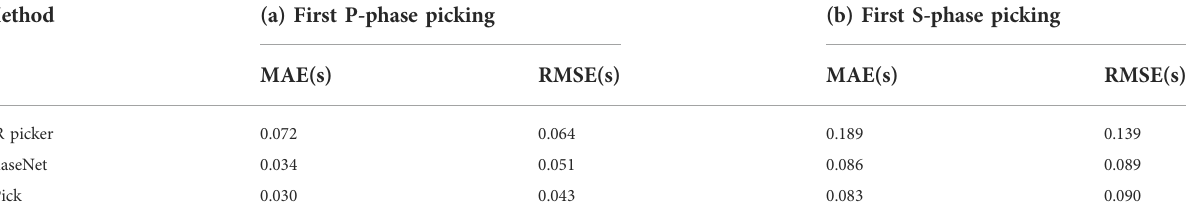
TABLE 3 Seismic phase picking on the INSTANCE dataset (Michelini et al., 2021). MAE and RMSE are the mean absolute error and root mean squared error of the arrival time errors (prediction-ground truth) in seconds, respectively. Here, the absolute arrival-time error below 0.5 s is considered.